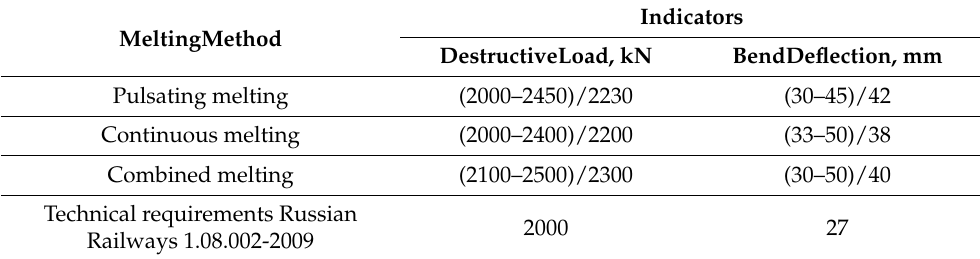
Table 4. Results of statistical tests of rail